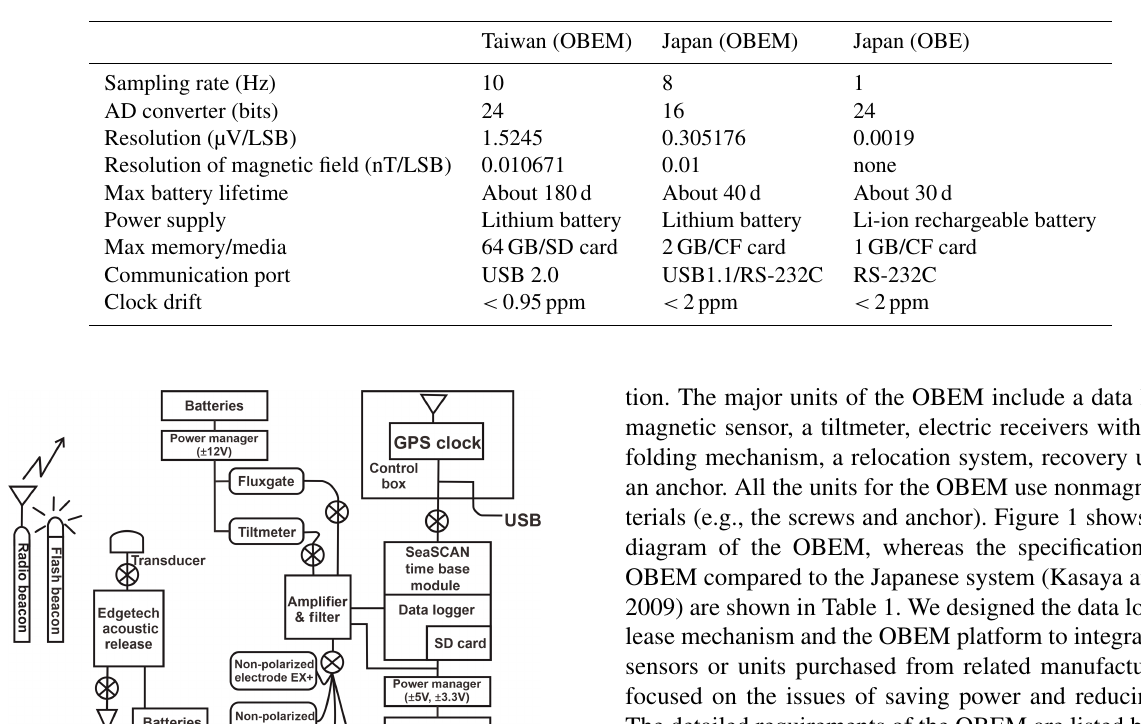
Table 1. Specifications of the OBEM compared to the Japanese OBEM and OBE (Kasaya and Goto, 2009).